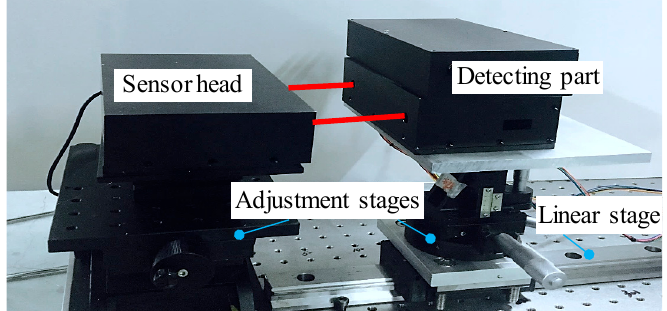
Figure 5. Experimental setup of the prototype laser measurement system (LMS).